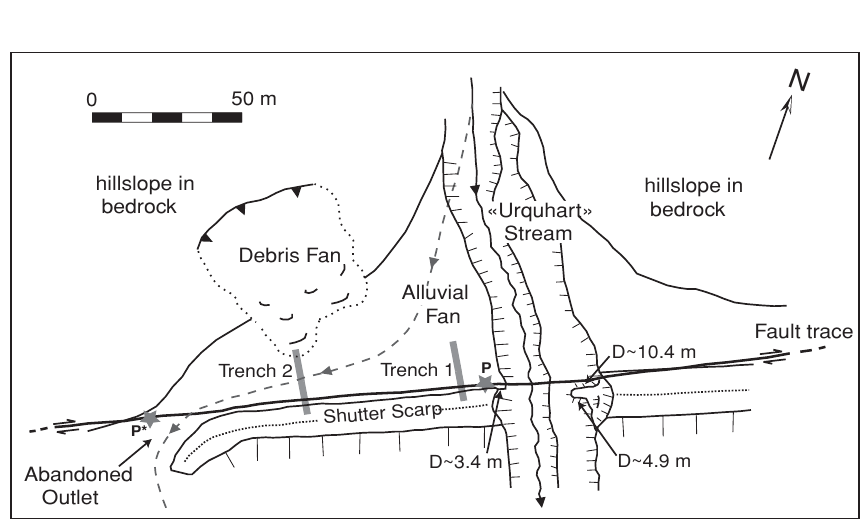
Fig. 5. Simplified geomorphic sketch of the trench site (modified after Pope, 1994). Modern incised Urquhart Stream crosses the fault but was formerly deflected dextrally and drained through the abandoned outlet. The fault deflection P to P * is marked by stars. Inferred measured single event dextral (D) displacement values (in metres) are shown. Trench 2 clips deposits of the landslide lobe at its northern end as shown on